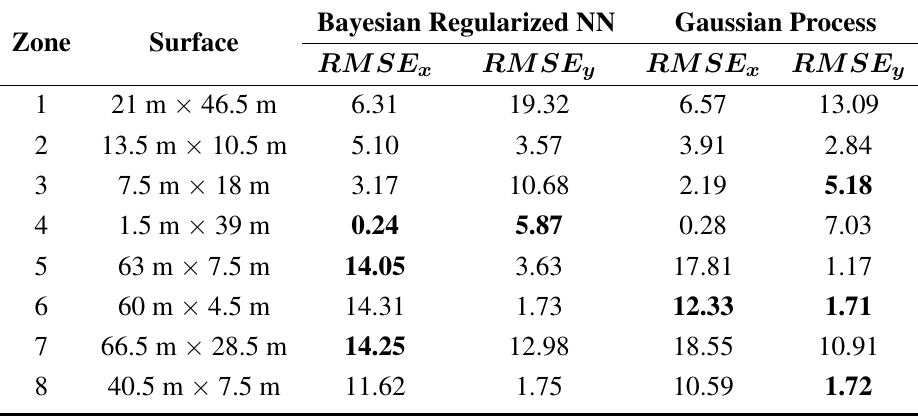
Table 4. RMSE (meters) using only intensities based on automatically-clustered data in Building A.